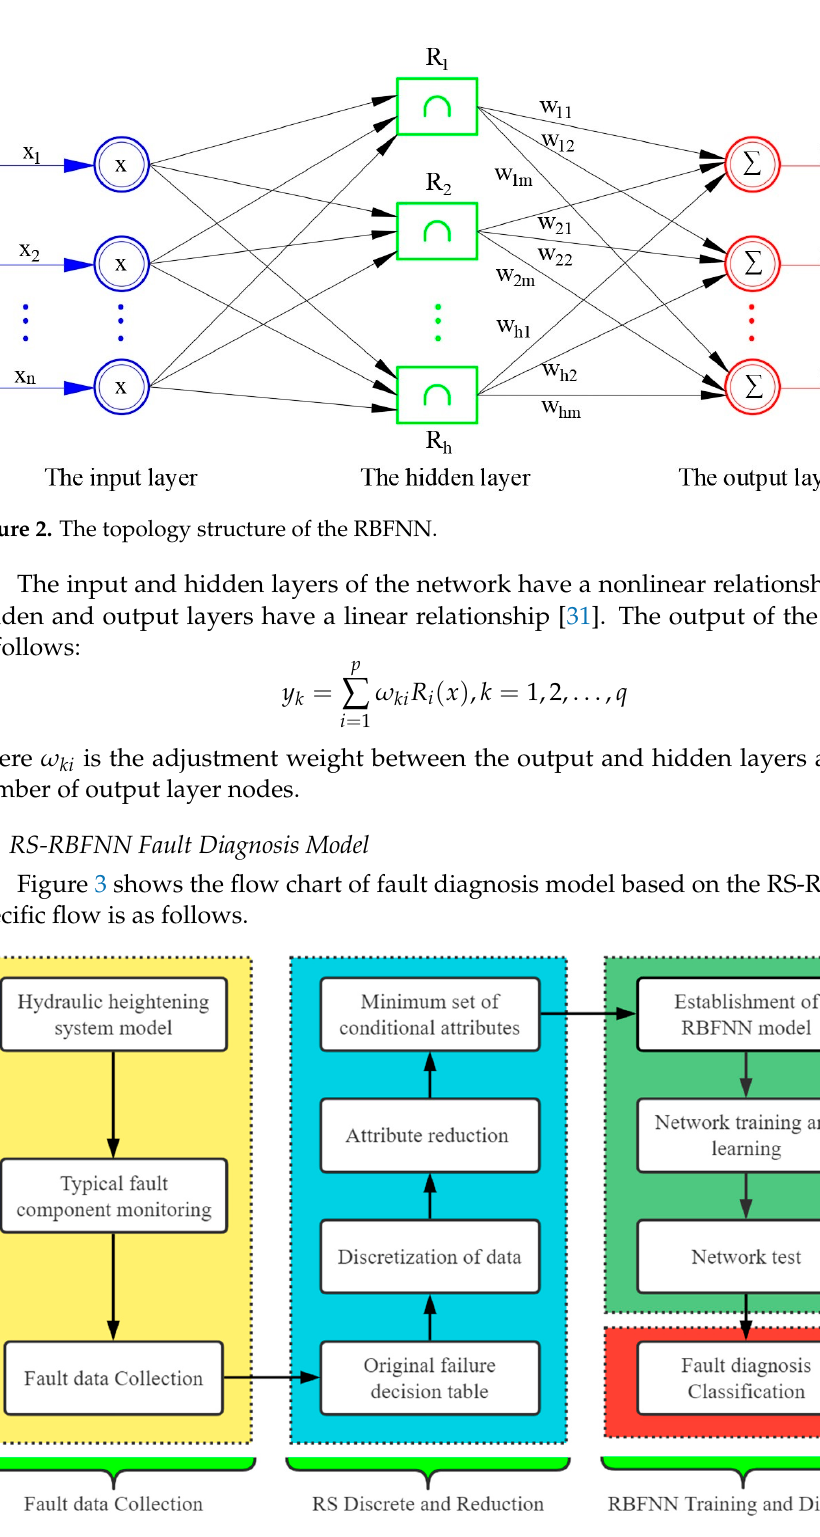
Figure 4. The schematic diagram of the hydraulic heightening system. 3.2. Simulation Model